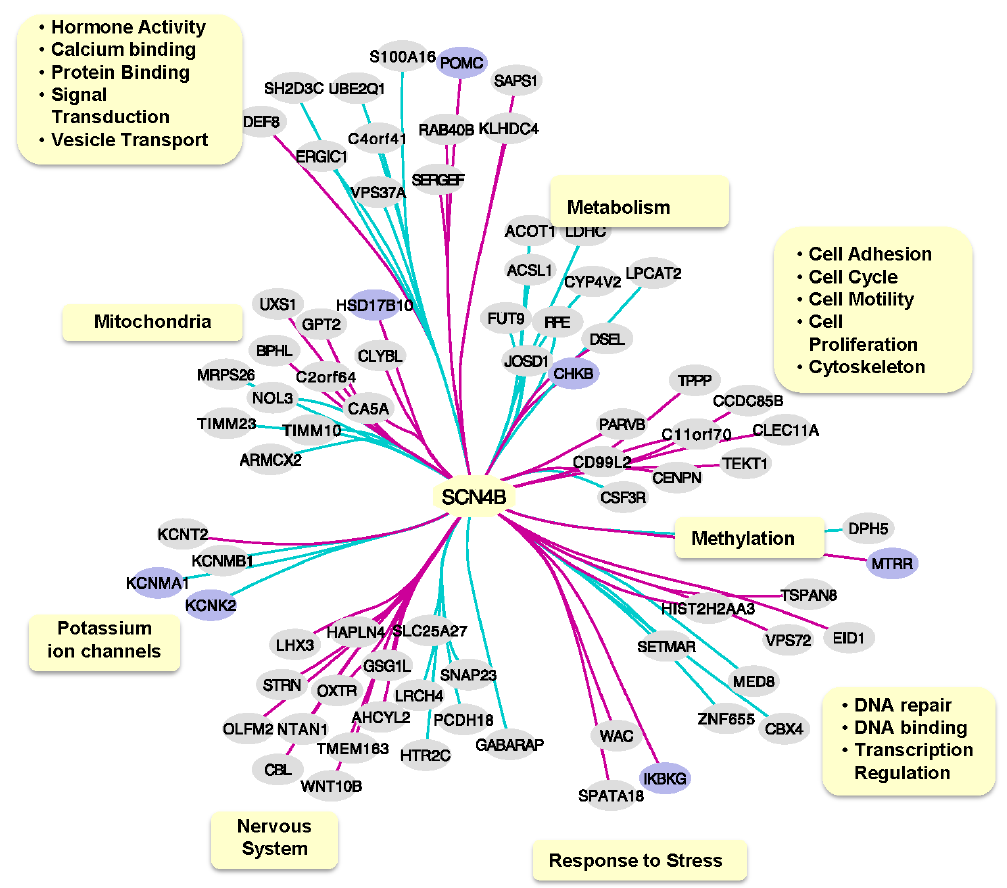
Figure 3. Scheme summarizing 77 genes co-expressed with SCN4B (FDR < 0.05) and their functional annotation. An overview of their functional groups is presented on yellow boxes, based on associated gene ontology terms. Blue nodes indicate genes previously associated to epilepsy according to DisGeNET database. Green edges indicate negative correlation, while magenta edges indicate positive correlation. Blue lines: positive co-expression. Purple lines: negative